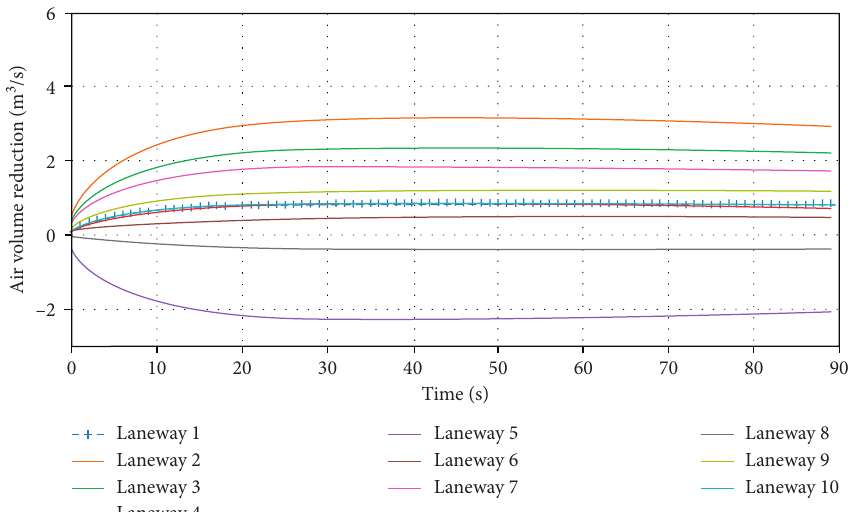
Figure 5: Air volume reduction for each laneway with mine car moving to windward.